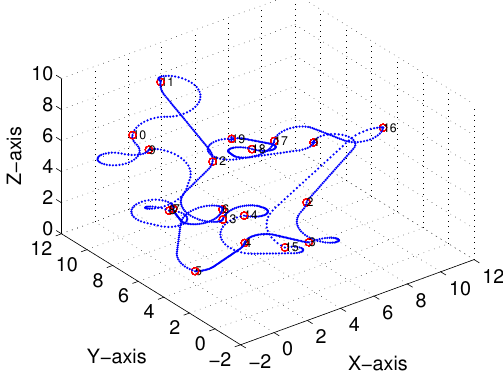
Figure 13. Bezier interpolation based three-dimensional (3D) Dubins curves (case